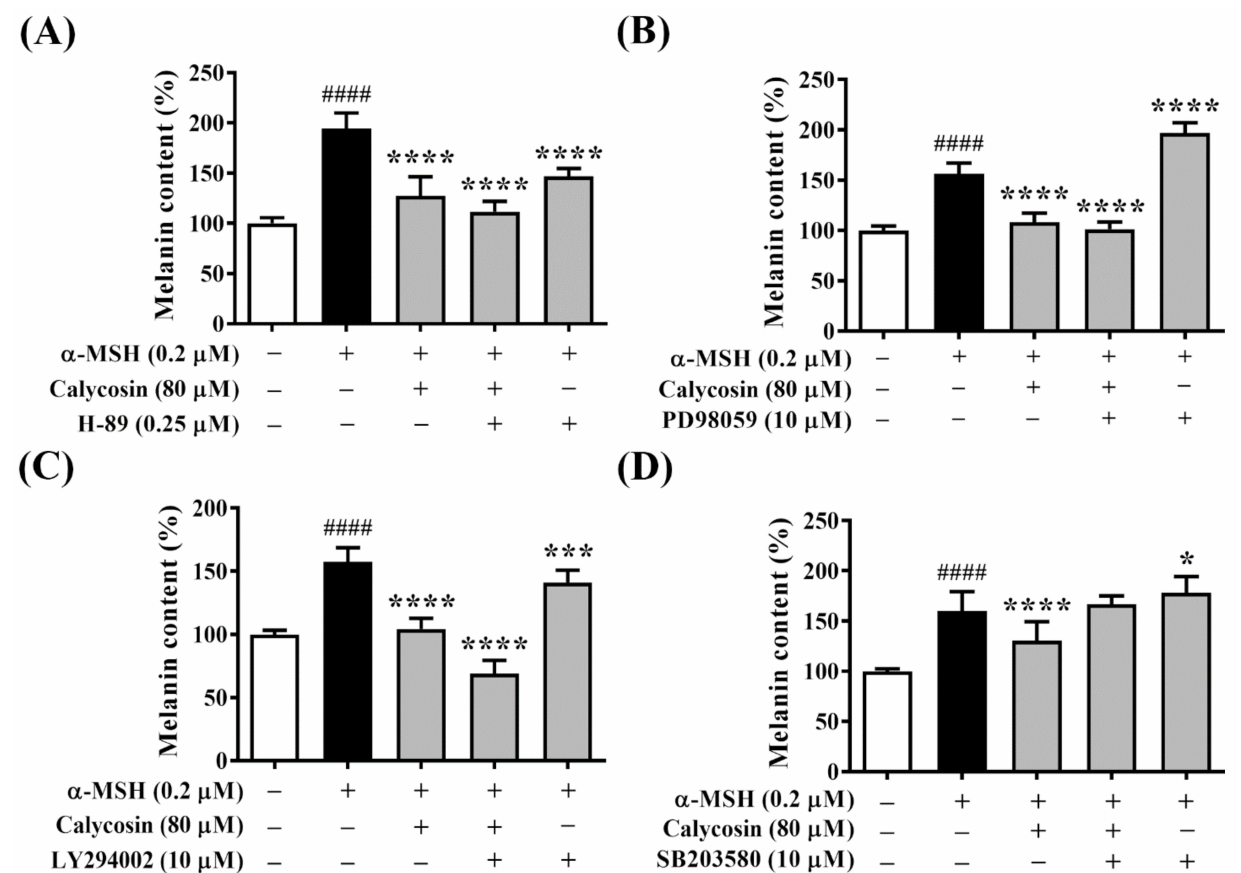
Figure 5. Effects of Calycosin on the melanogenesis signaling pathway. ( A ) Effect of calycosin and H-89 (PKA inhibitor) on melanin content (%) in α -MSH-treated B16F10 cells for 48 h. ( B ) Effect of calycosin and PD98059 (MAPK/ERK inhibitor) on melanin content (%) in α -MSH-treated B16F10 cells for 48 h. ( C ) Effect of calycosin and LY294002 (PI3K/Akt inhibitor) on melanin content (%) in α -MSH-treated B16F10 cells for 48 h. ( D ) Effect of calycosin and SB203580 (p38 inhibitor) on melanin content (%) in α -MSH-treated B16F10 cells for 48 h. Data are represented as the means ± S.D. from three independent experiments. Significant difference versus control: #### p < 0.0001. Significant difference versus α -MSH-treated group: * p < 0.05, *** p < 0.001, **** p <